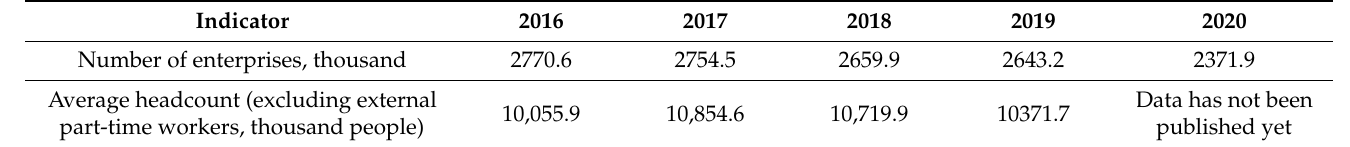
Table 2. The number of small enterprises (including microenterprises) and their employment in